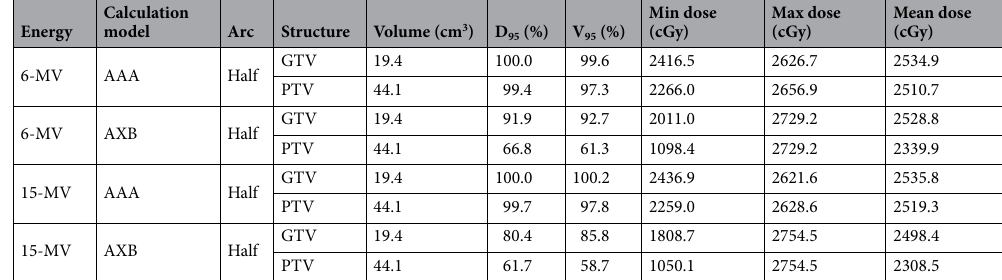
Table 3. Dose statistics of targets (GTVp and PTV_25) from half arcs volumetric modulated arc therapy (VMAT) plans.